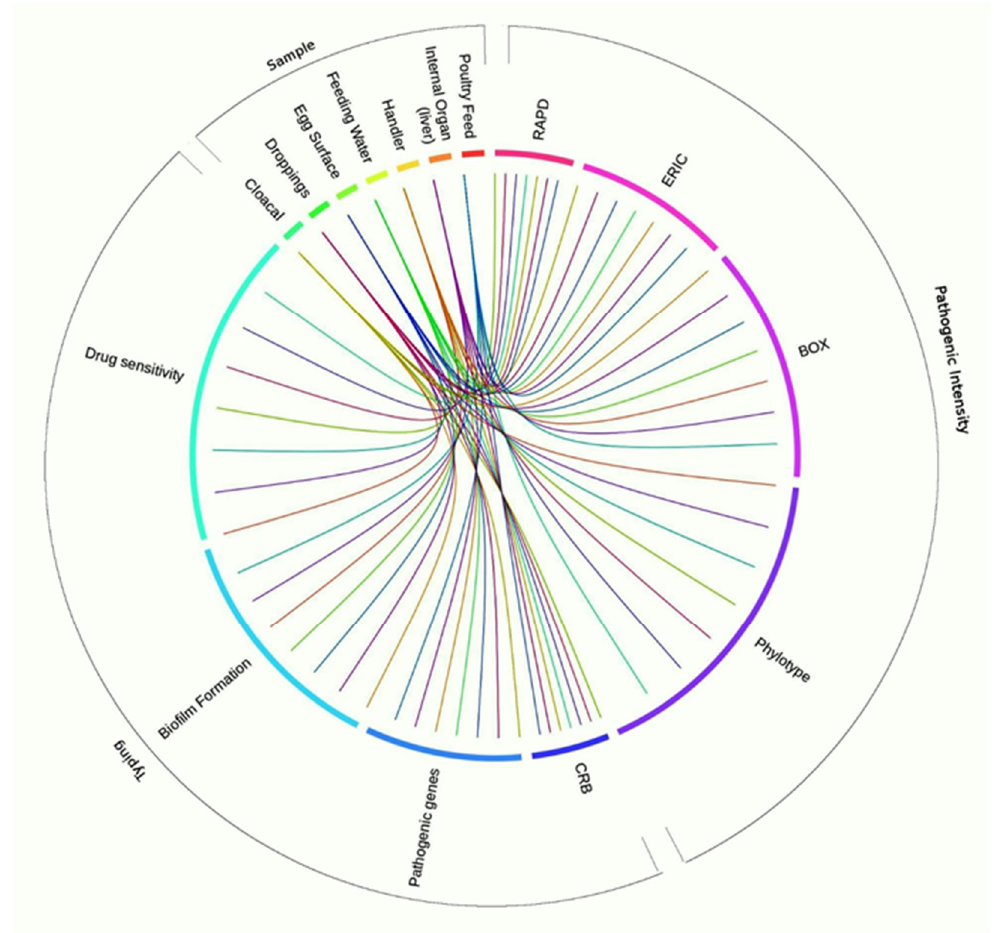
Figure 8. Circos plot representation of association of different sample types with molecular typing and pathogenic intensity characterization of E. coli . The association showed significant ( p = 0.032) correlation. The frequency of occurrence of different features, such as sample categories, typing, and pathogenicity patterns, is depicted in the outer ring. The inner ring of Circos plot depicts the correlation between the sample categories (cloacal, droppings, egg surface, feeding water, handler, internal organ, feed) and molecular typing (RAPD, ERIC, BOX, phylotype) and pathogenic intensities (CRB, pathogenic genes, biofilm formation, drug sensitivity). Each factor has been assigned to a color. The arc originates from sample types and terminates at typing and pathogenic intensity levels to compare the association between the origin and terminating factors. The area of each colored ribbon depicts the frequency of the samples related with the particular typing and pathogenic intensity expression.